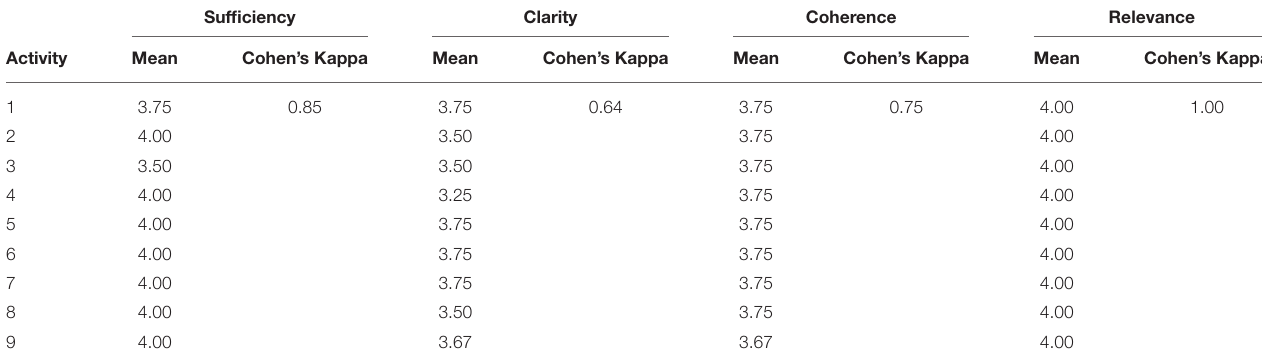
TABLE 4 | Results from the peer assessment process.